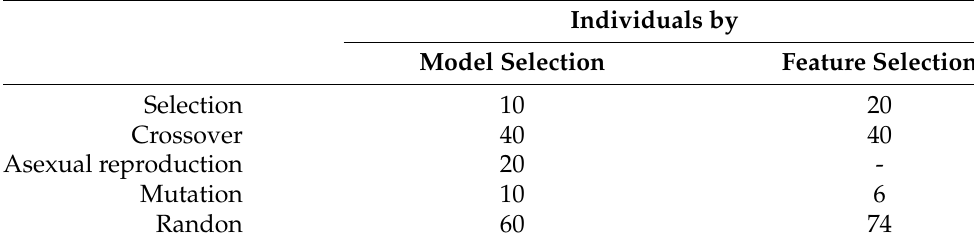
Table 3. Individuals generated by each reproduction